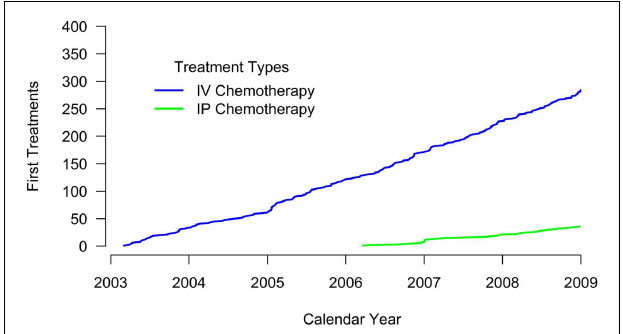
FIGURE 1 | Cumulative count of first treatments .The blue line shows the cumulative count of initial IV chemotherapy administrations over time. The green line shows the cumulative count of initial IP chemotherapy administrations over time.Treatment receipt was not mutually exclusive. For example, if a woman received both IV and IP chemotherapy, her first treatment for each modality is included in the